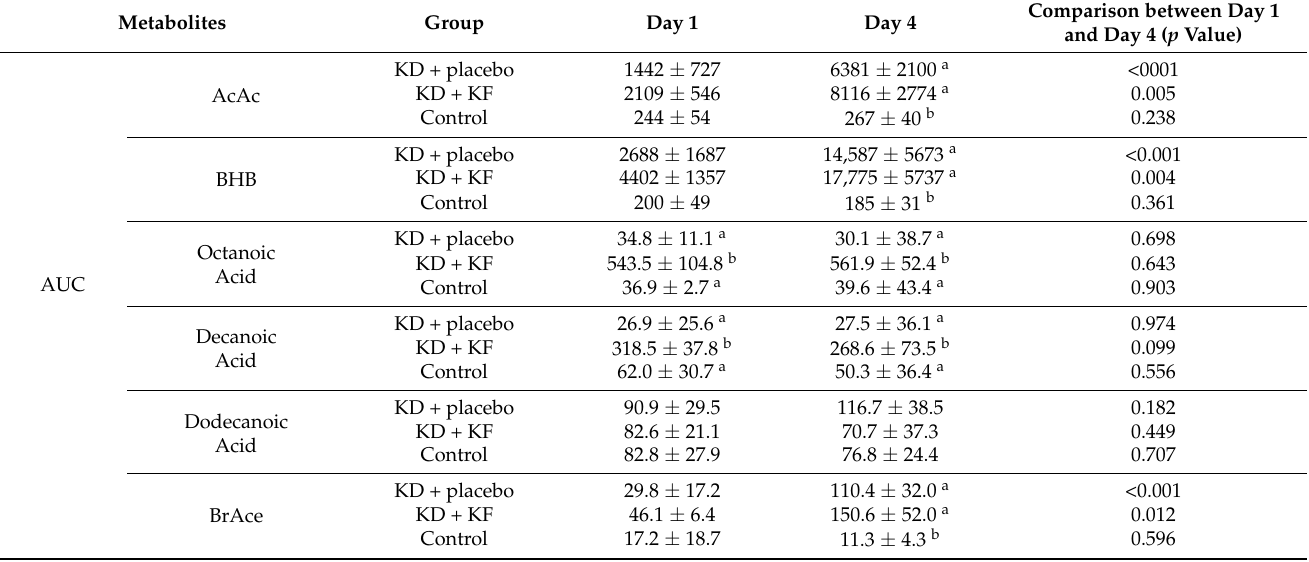
Table 3. Comparison of secondary endpoints, before and after